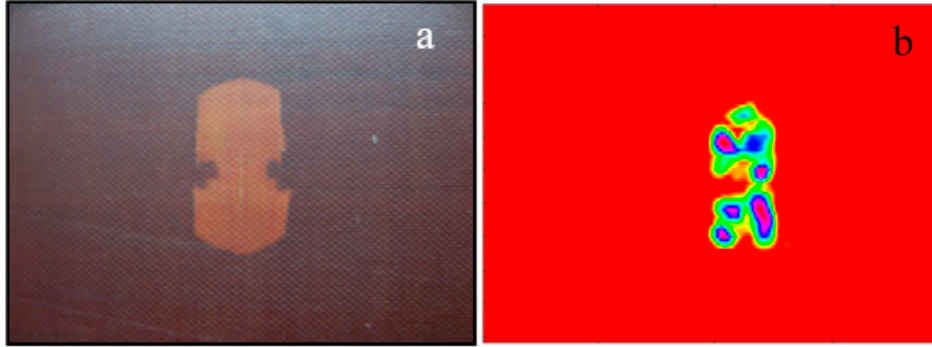
Figure 11. (23 + 24 HH) AE image ( b ) of the delamination in composite plate ( a ).